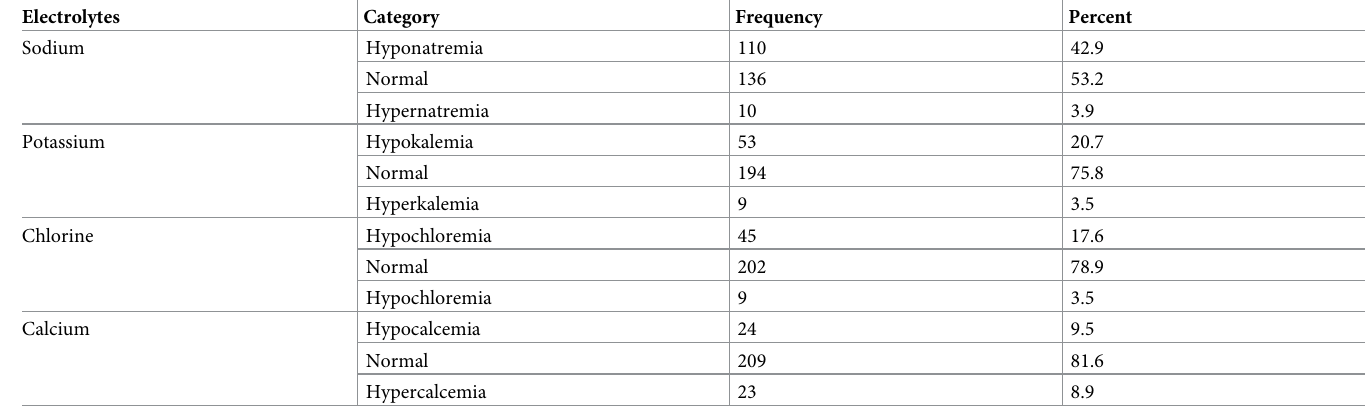
Table 2. Electrolyte status of patients admitted to medical ward with metabolic syndromes, in Jimma Medical Center, South west Ethiopia from April-May 2019. Electrolytes